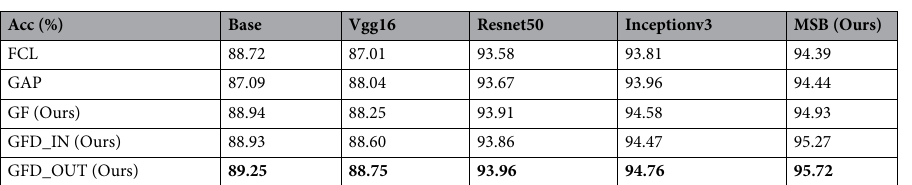
Table 1. The comparisons of different networks and different embedding structure. Acc means the 20-way one-shot recognition accuracy on Omniglot dataset. The best-performing method is bolded.